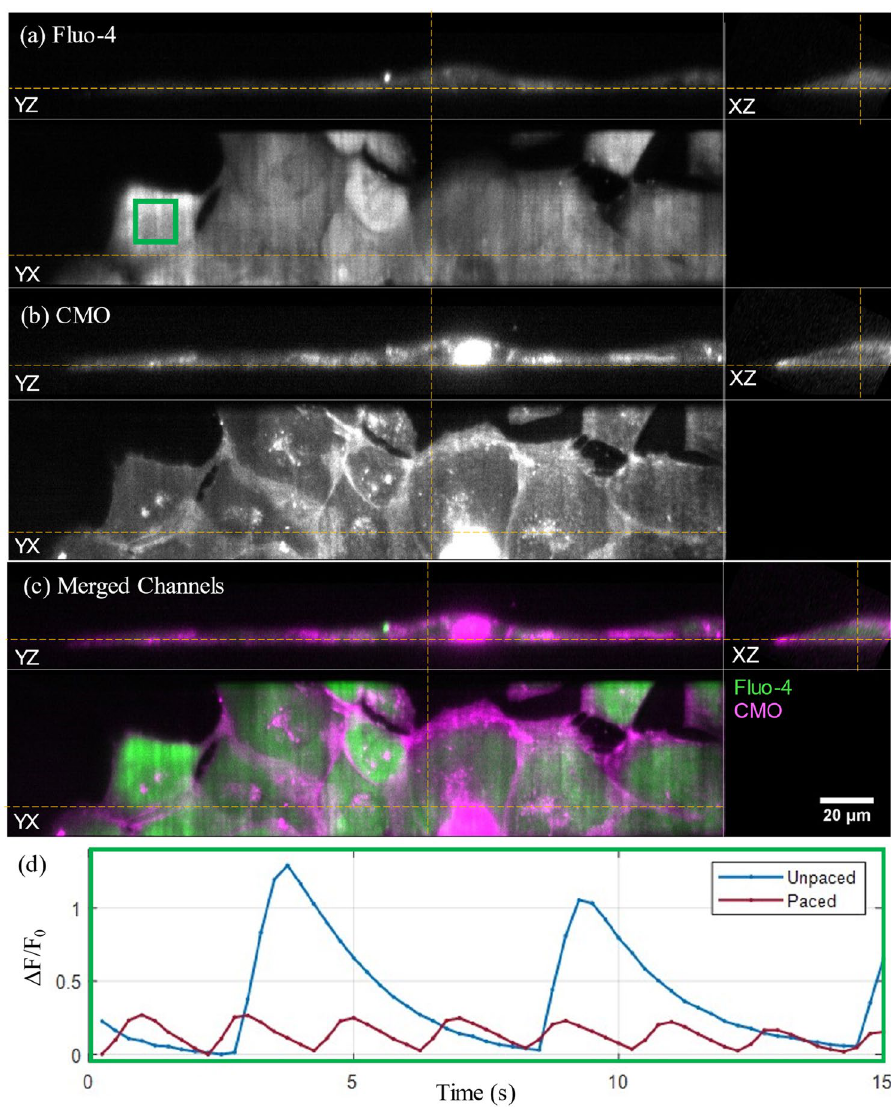
Figure 2. 3D LSFM imaging of spontaneous and stimulated calcium transients in hiPSC-CM. Orthogonal cuts through the ( a ) Fluo-4, ( b ) CMO and ( c ) merged channels of hiPSC-CM culture imaged in 3D at 4 vps, 195 fps, displayed at the peak of the first spontaneous transient (t = 3.75 s) during an unpaced acquisition—the corresponding timelapse is shown in Supplementary Video 1. The yellow dashed lines indicate the intersecting planes of the displayed orthoslices. ( d ) Calcium transient ΔF/F 0 time traces calculated over the three- dimensional 100 × 100 × 1-voxel ROI [green rectangle in ( a )] in consecutive unpaced and paced (at 0.5 Hz) acquisitions of the same